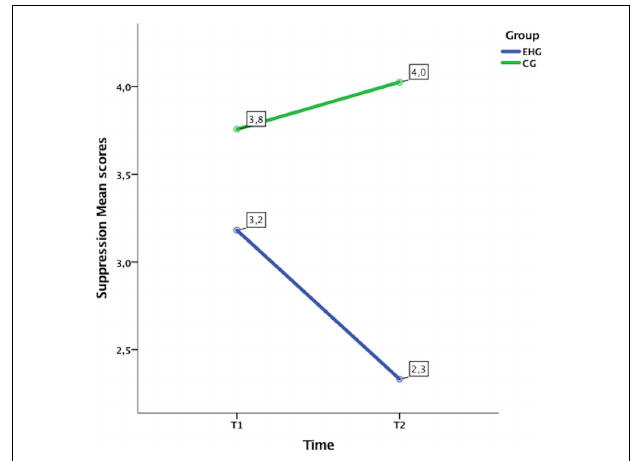
FIGURE 4 | Emotional Well-being significant interaction effect time × group from ANCOVA